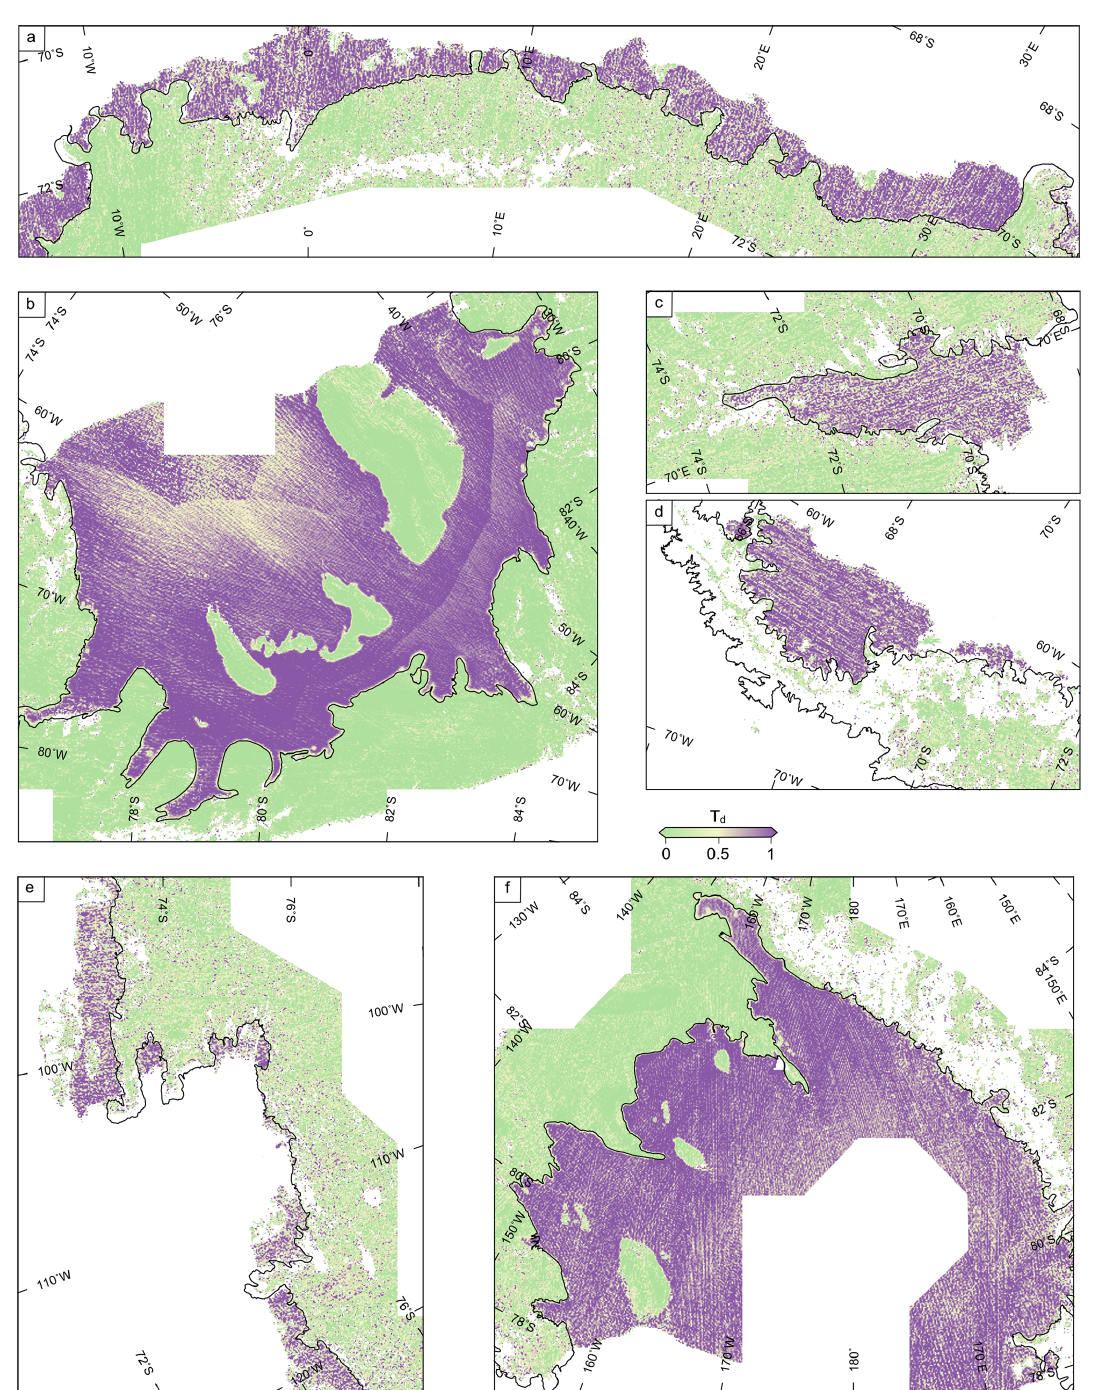
Figure 2. The dimensionless tidal amplitude, T d , for (a) Dronning Maud Land, (b) Filchner–Ronne Ice Shelf, (c) Amery Ice Shelf and (d) Antarctic Peninsula. (e) Amundsen Sea sector and (f) Ross Ice Shelf. The black line is a composite grounding line by Depoorter et al.